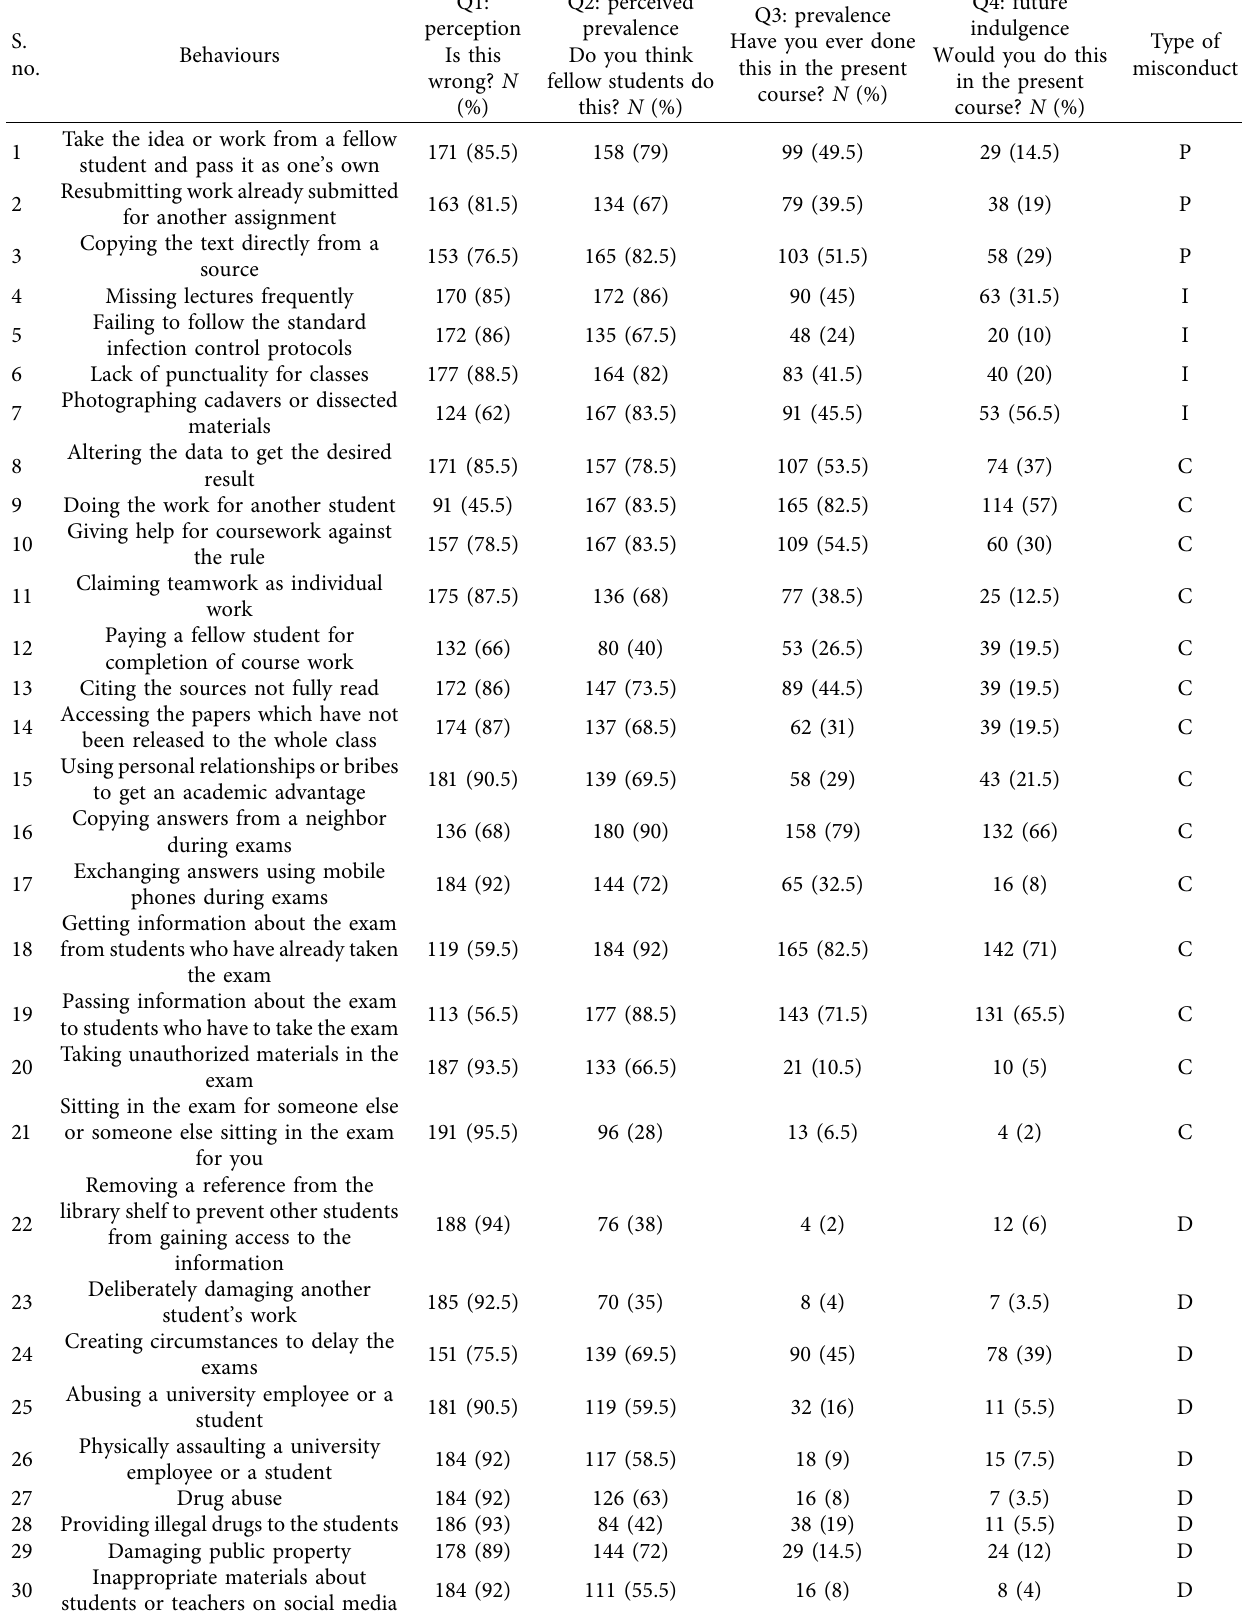
Table 1: Self-reported behavior of medical students regarding academic dishonesty.